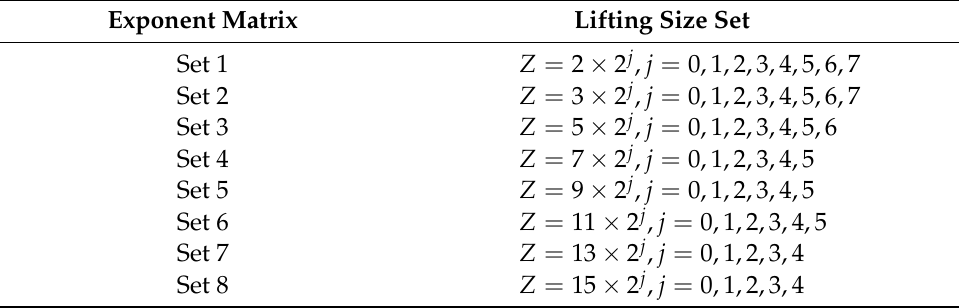
Table 1. Relationship between exponent matrices and sets of lifting